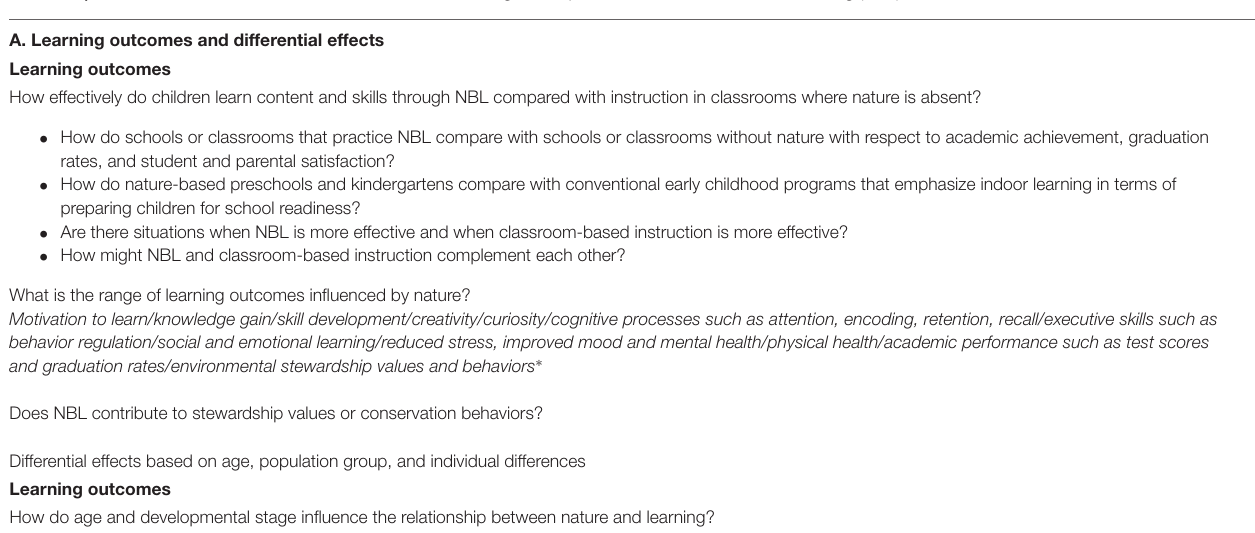
TABLE 1 | A framework for research to advance the understanding and implementation of nature-based learning